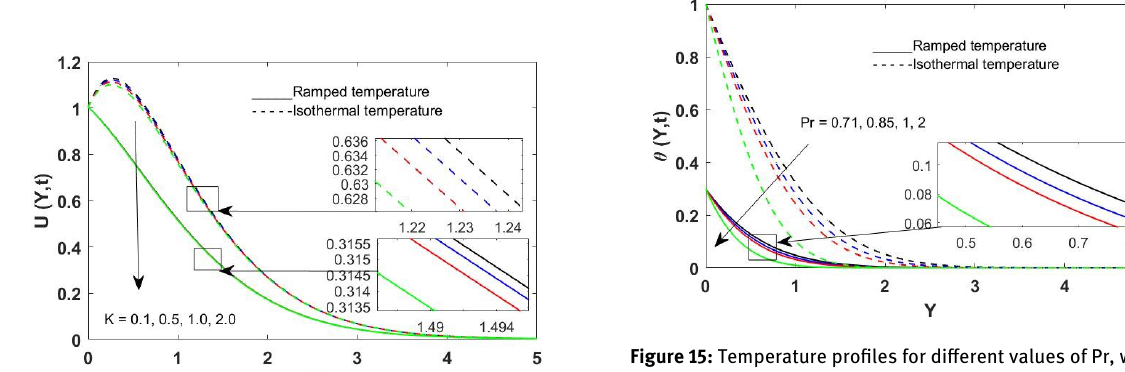
Figure 11: Momentum distribution versus Pr t =0.3, R=0.2, S=1, K=1, Q=0.2, kp=1.5, E=1, Ω = 30 0 , ψ = 0.5 , Sc =0.60, Gr=3, Gc=4